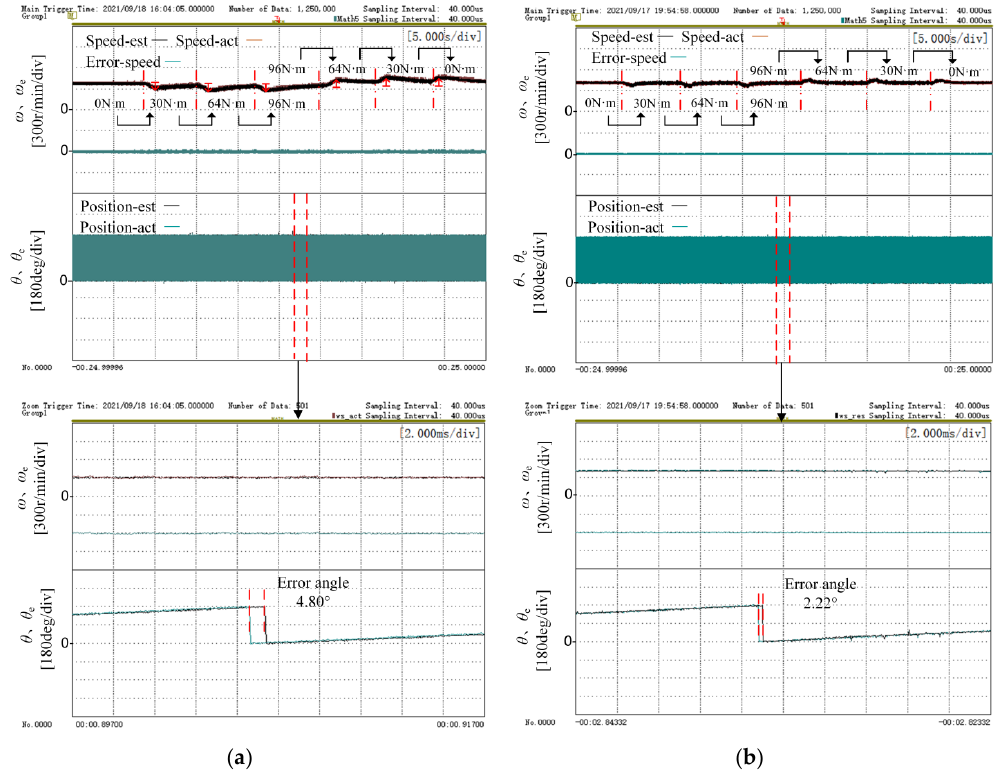
Figure 15. The speed control of tested motor with traditional method and proposed method at 400 r/min: ( a ) traditional method; ( b ) the proposed method. 400 r/min: ( a ) traditional method; ( b ) the proposed